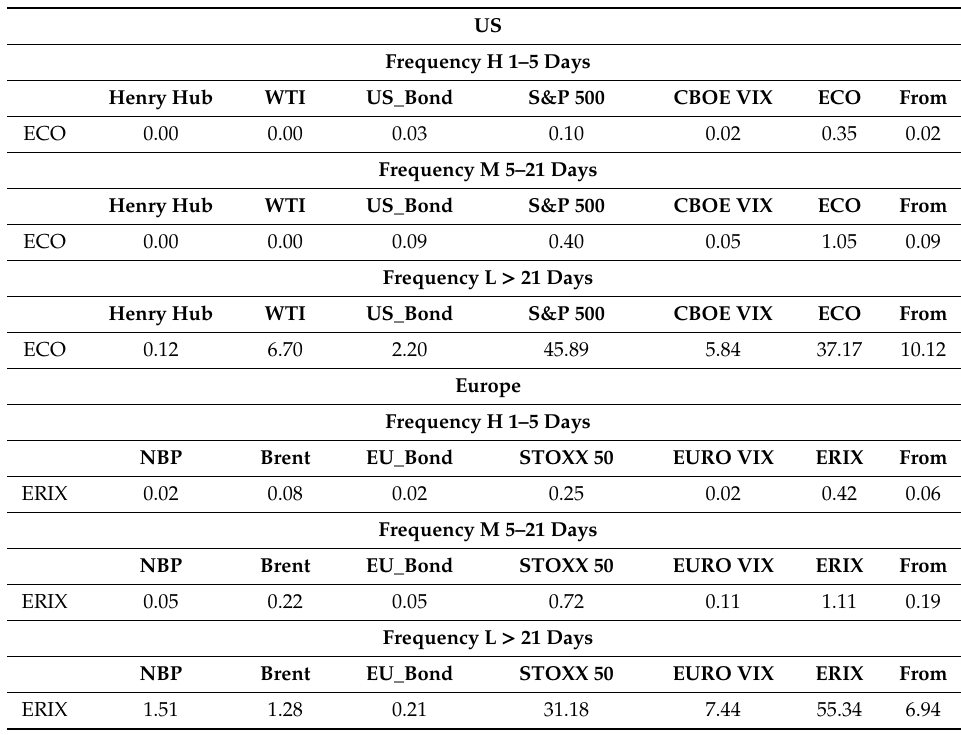
Table 7. Volatility spillover